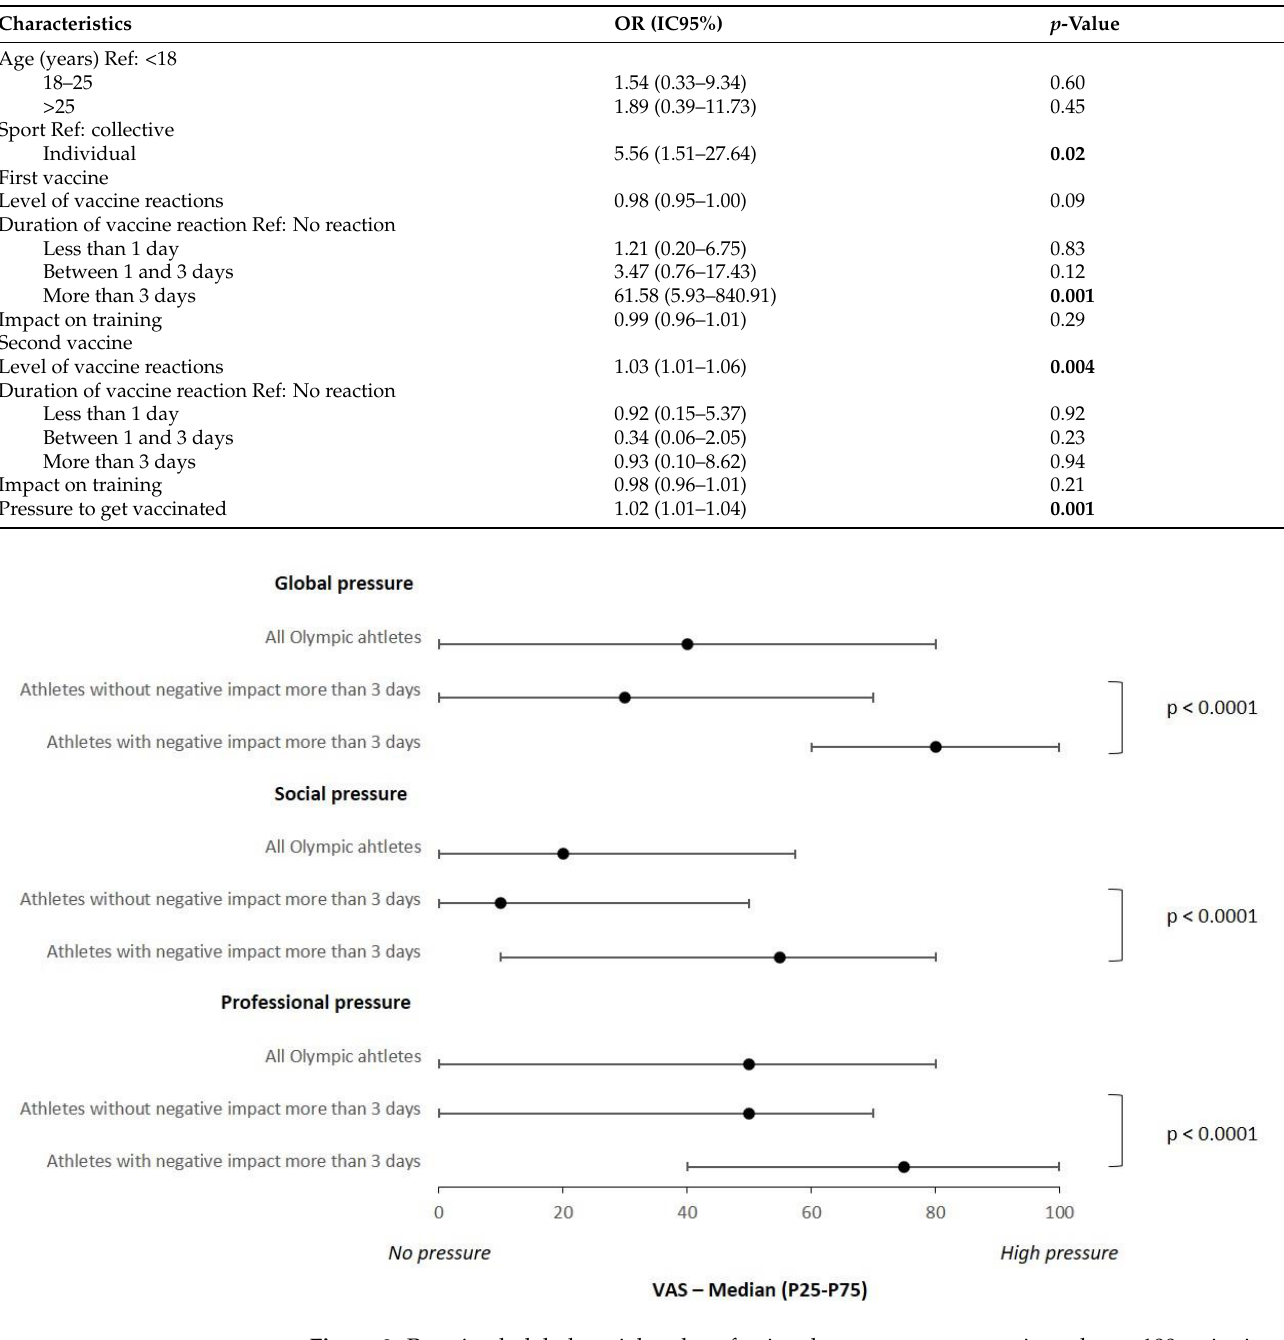
Table 4. Logistic regression on the probability to have a negative impact on physical performance of more than 3 days after the full COVID-19 vaccination ( n = 294).